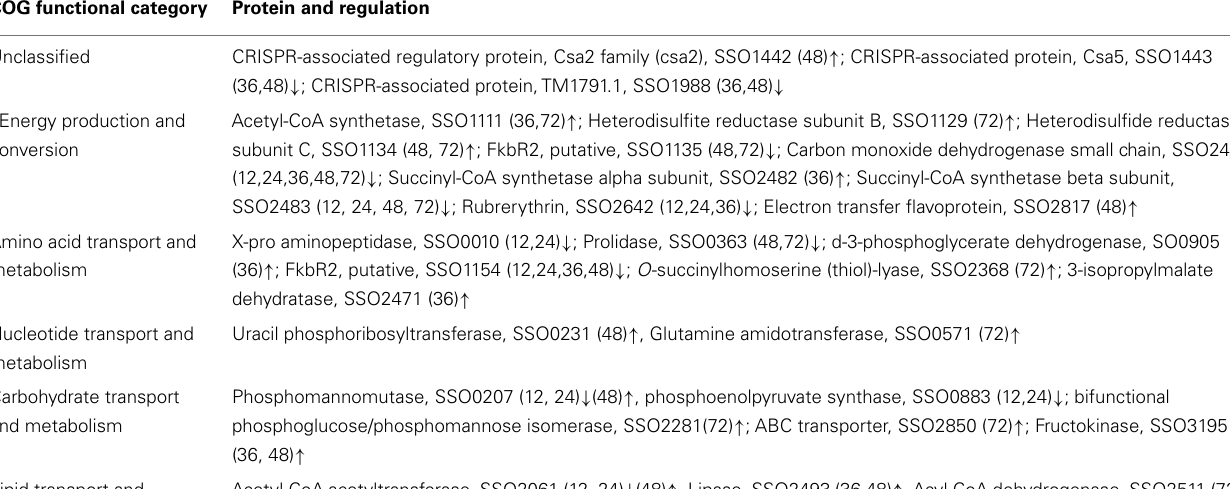
Table 1 | 2D-DIGE identified proteins organized within